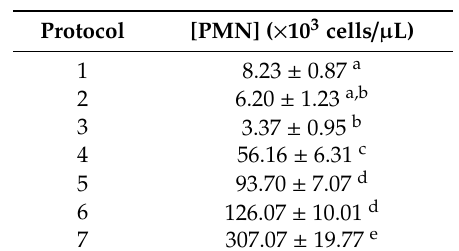
Table 1. PMN concentration ( × 10 3 cells / µ L) obtained after conducting di ff erent PMN isolation protocols (Experiment 1).